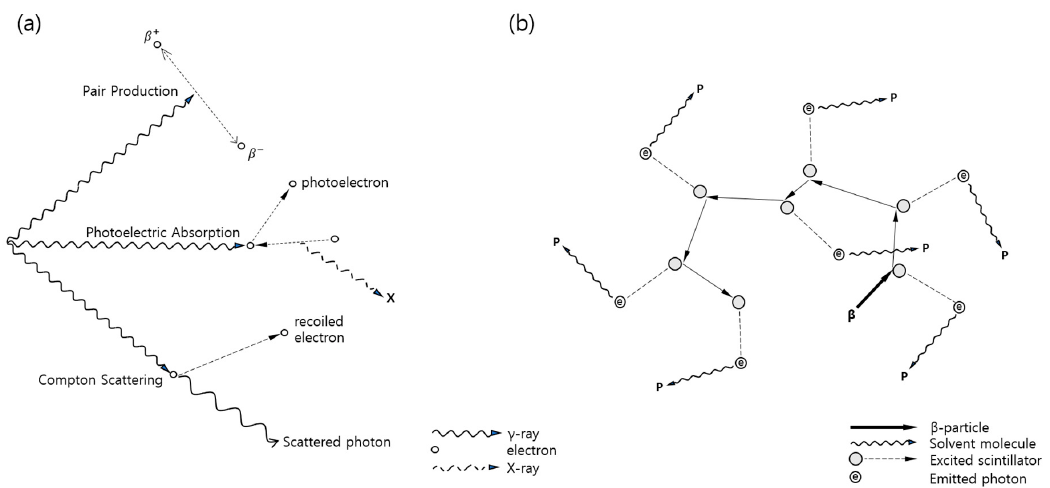
Figure 1. Radiation interaction in scintillator ( a ) gamma-ray interaction and ( b ) beta-ray interaction.